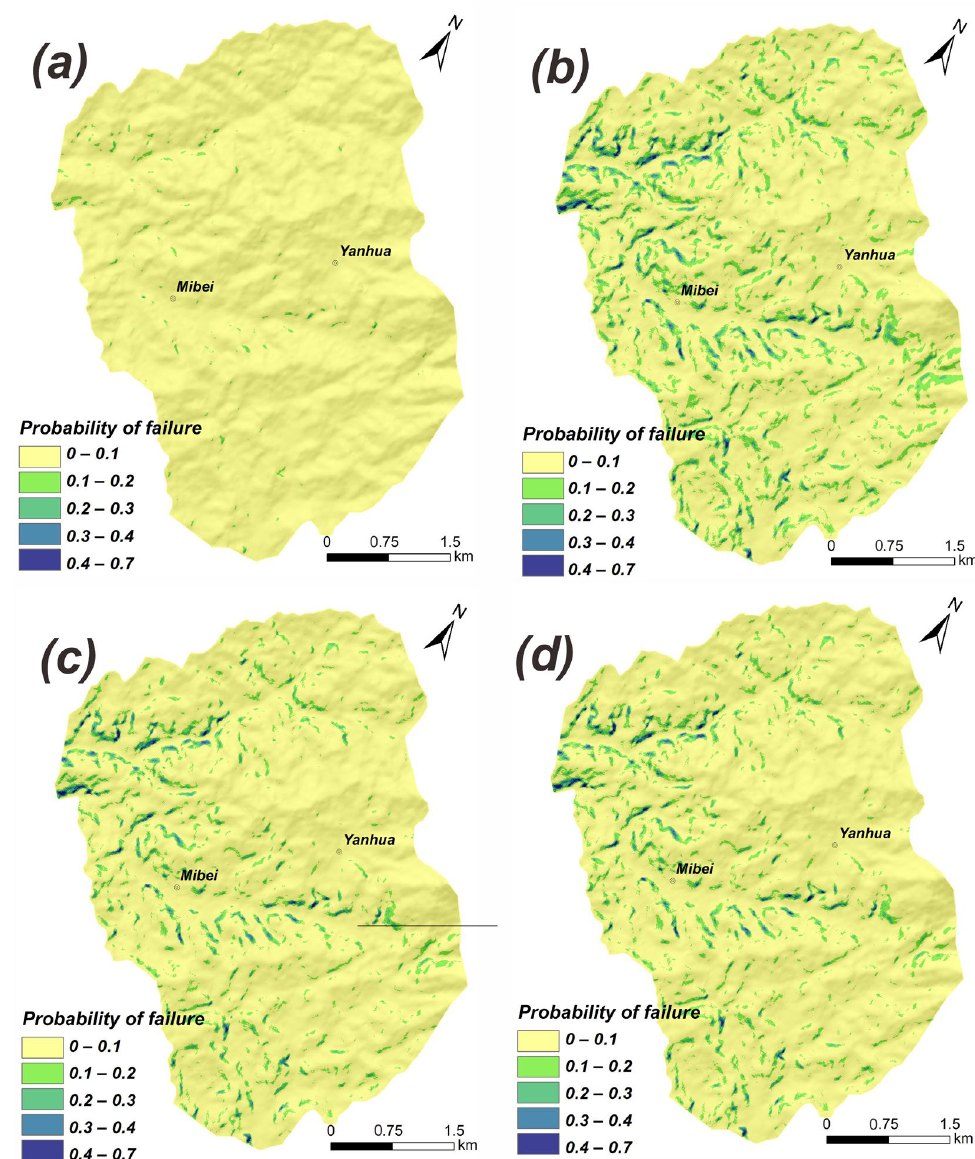
Figure 20. Probability of slope failure (Pf) in different time periods of this rainfall event; ( a ) before rainfall event; ( b ) 8:00 on 10 June 2019; ( c ) 20:00 on 11 June 2019; ( d ) 8:00 on 13 June 2019.